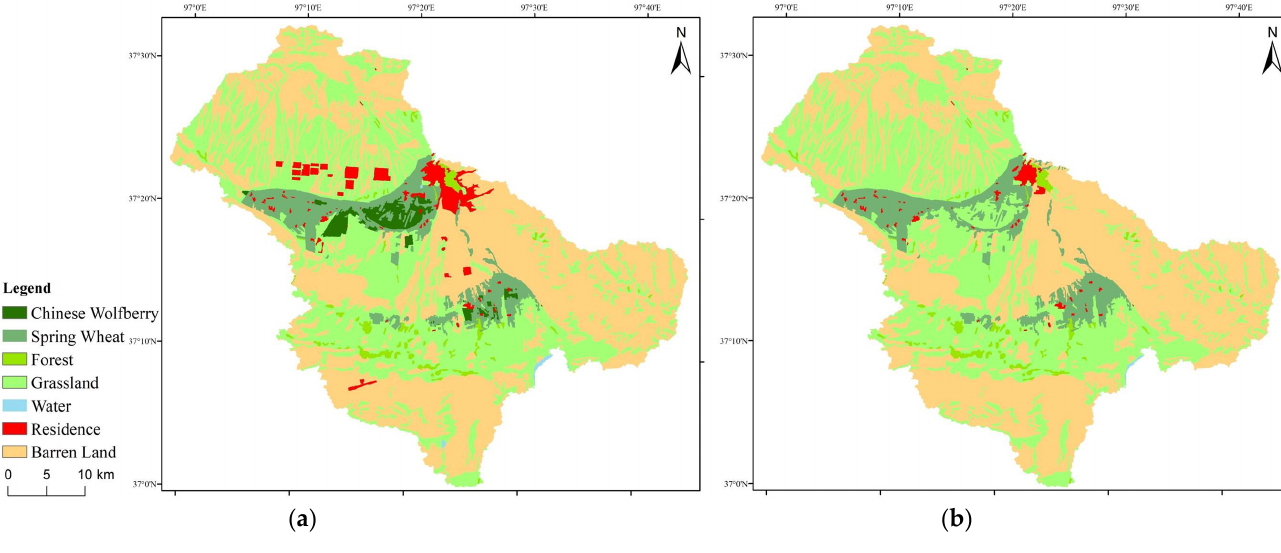
Figure 7. Initial groundwater head for MODFLOW. 2.5. Model Calibration The years 2000–2001 were used as the model warm ‐ up period, 2002–2011 as the model calibration period, and 2012–2018 as the model validation period. Vegetation growth parameters in the SWAT model were calibrated at HRU scales against the monthly 30 m resolution LAI data of 2002–2018 provided by the National Tibetan Plateau/Third Pole Environment Data Centre [29]. The dataset is the fusion of MODIS LAI and observed LAI in Qilian mountainous area (including the Qaidam Basin). ET simulated by the LU ‐ SWAT ‐ MODFLOW model was calibrated at sub ‐ basin scales against the ET data at a 0.1° × 0.1° resolution (Figure 8) provided by the National Tibetan Plateau/Third Pole Environment Data Centre [29]. The dataset is derived by employing a